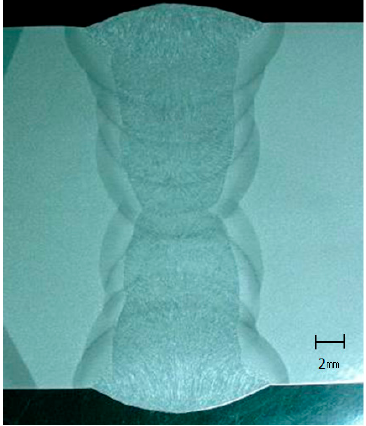
Figure 2. Macro test results of NGW.